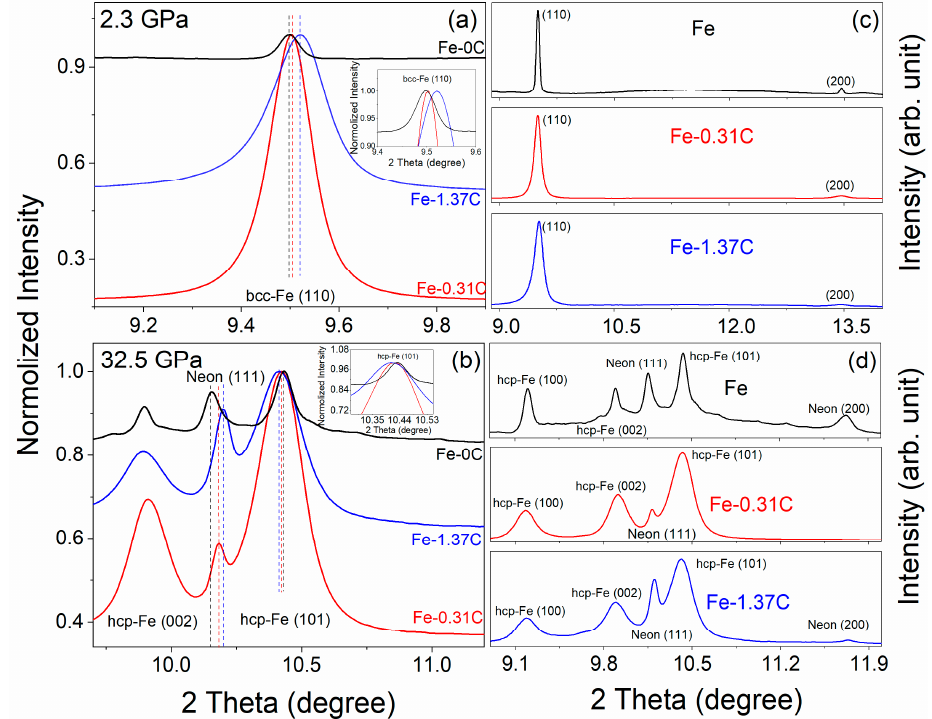
Figure 1. Representative X-ray diffraction (XRD) patterns for Fe-C samples in ( a , c ) selected peaks and full XRD patterns of the body-centered tetragonal (bct) structure at 2.3 GPa and ( b , d ) selected peaks and full XRD pattern of hcp structure at 32.5 GPa, using Au as first-order pressure calibrant. Insert in ( a ) shows the zoom-in of the (110) peak of body-centered cubic (bcc)-Fe and ( b ) zoom-in of (101) and (002) peaks of hcp-Fe. Fe-0C (pure Fe), Fe-0.31C, Fe-1.37C, and Au are loaded in the same sample chamber using neon as the pressure medium. Black, red and blue curves are for Fe-0C, Fe-0.31C and Fe-1.37C, respectively. Neon (111) peak shift in each pattern for Fe-0C, Fe-0.31C and Fe-1.37C under 32.5 GPa indicates non-hydrostatic pressure in the sample chamber, with Fe-0C under lowest pressure, and Fe-1.37C under highest pressure. Vertical dash lines are plotted to show the center of each peak and for comparison of peak